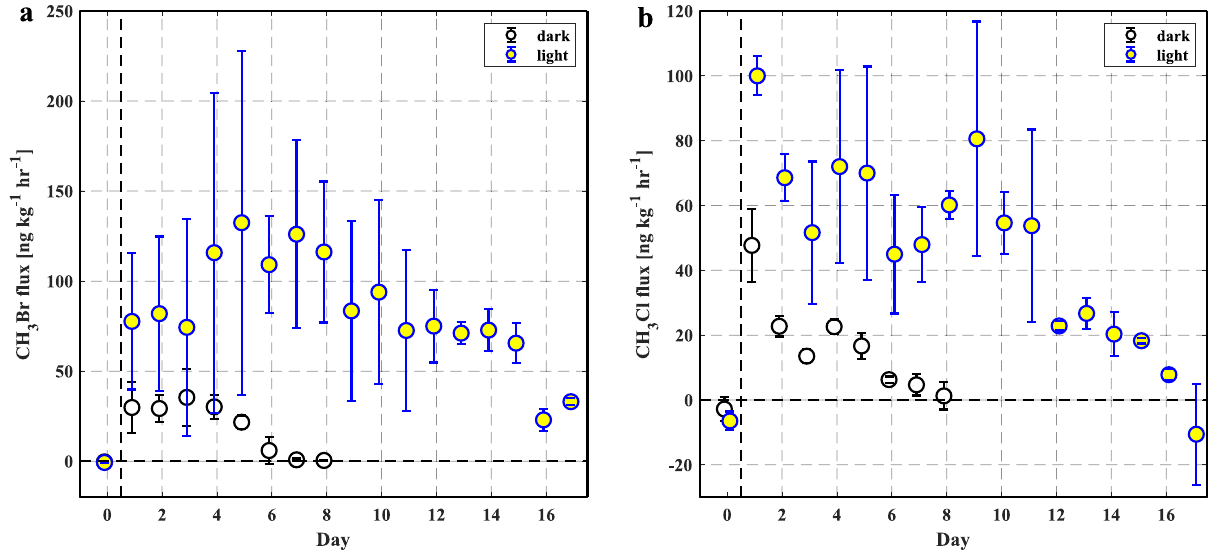
Fig. 3 Time-series fl uxes of methyl halide from soil samples. a Methyl bromide (CH 3 Br) and b methyl chloride (CH 3 Cl) from light vs . dark incubations of live soil samples. On day 1, 10 ml of 50 mM CuSO 4 was added to soil samples (50 grams); the dark incubation lasted for 8 days while the light incubation was 17 days. The circles represent the average fl uxes of triplicate incubations ( n = 3) and the error bars represent the standard